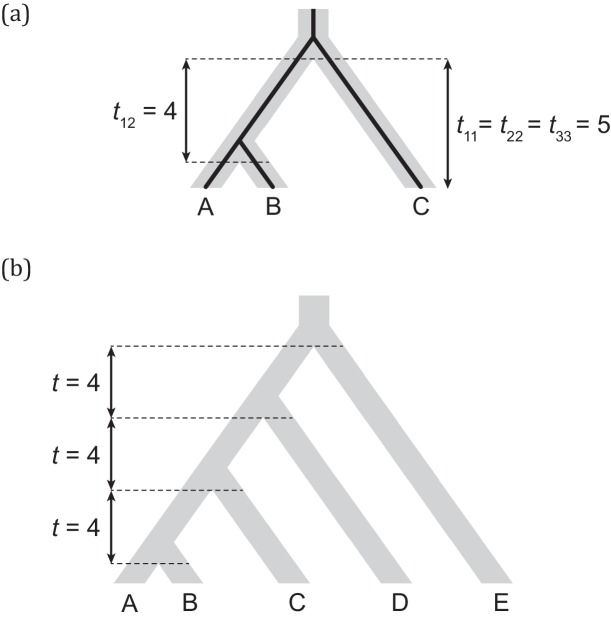
Divergence times, tij (tAB, t(AB)C and tMRCA for the species tree depicted in gray), and coalescence times, Tij,l (TAB,l, T(AB)C,l and TMRCA,l for genealogy l depicted in black).